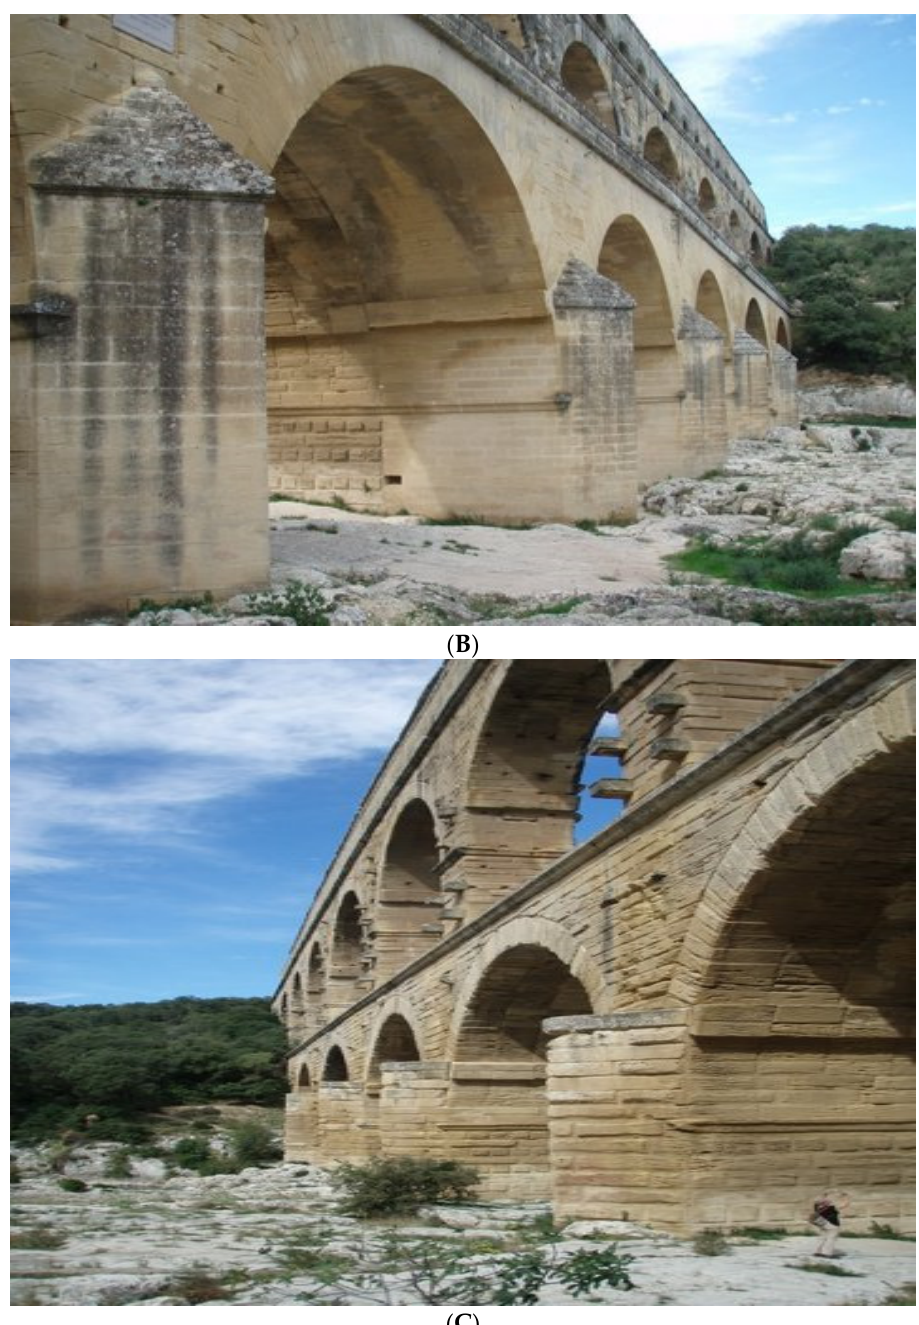
Figure 2. ( A ) The Pont du Gard aqueduct/bridge. ( B ) Later (1743–1747) roadway passage addition to the original Roman Aqueduct. ( C ) Base structure of the Aqueduct. Note foundation triangular structures to reinforce the aqueduct base and lower river water hydrodynamic pressure forces on the base structure.